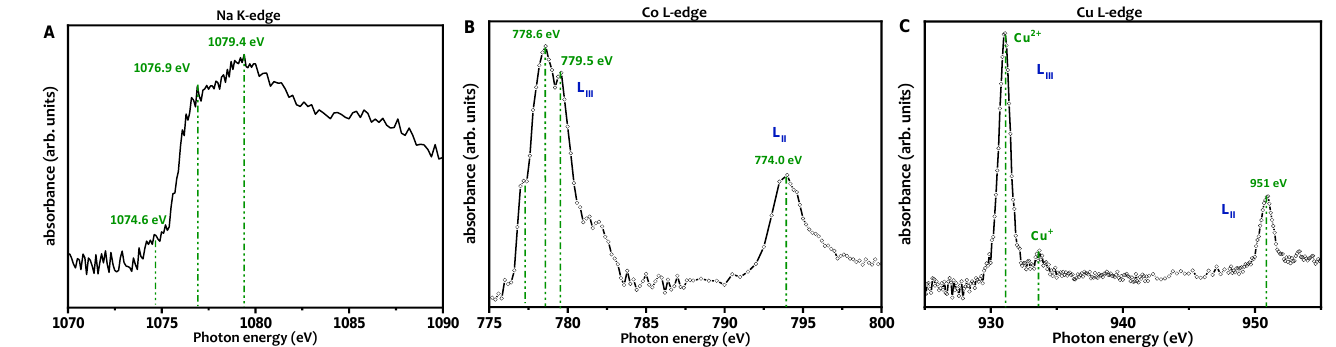
Figure 4. ( A ) Na K-edge NEXAFS of Na-abietate. ( B ) Co L-edge of Co-abietate. ( C ) Cu-L-edge of Cu-abietate.